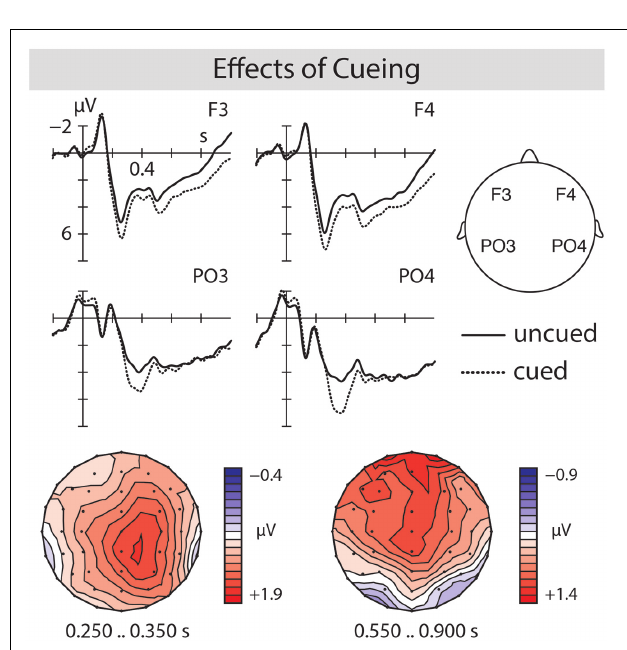
FIGURE 2 | Grand average ERPs for cued (dotted line) compared to uncued (solid line) sentence final words revealed a P300 emerging around 250 ms post-stimulus presentation. Topographic maps of the P300 are shown